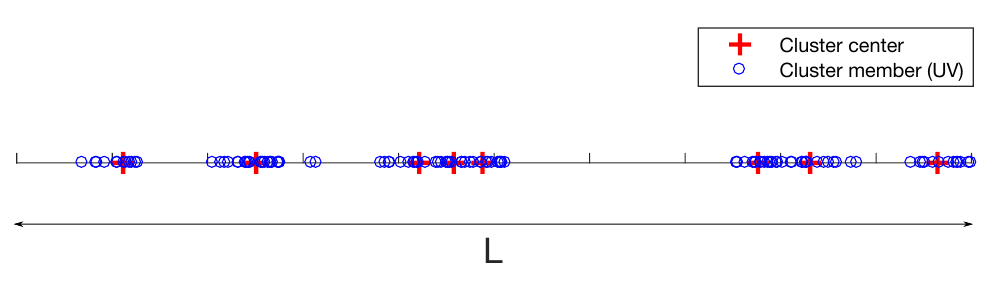
Figure 1. An example illustration of an one-dimensional clustered linear unmanned vehicle (UV) sensor network based on Thomas cluster process